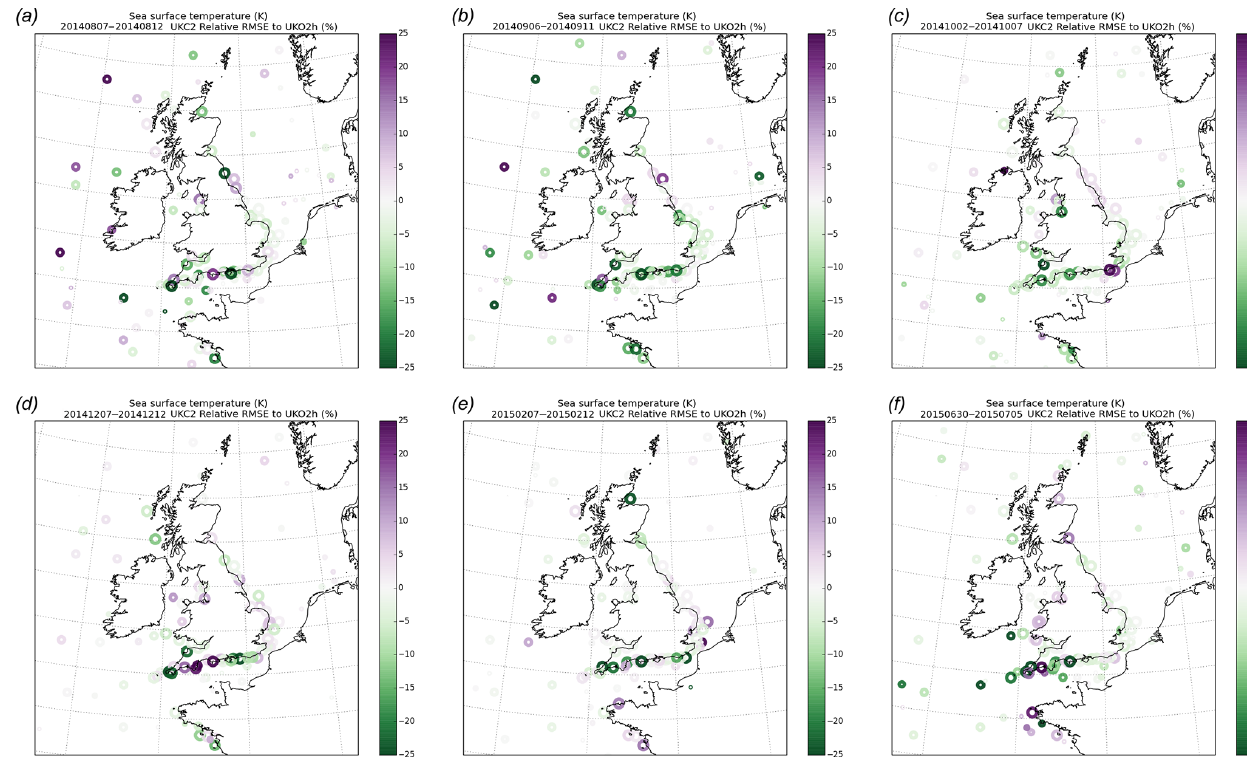
Figure 9. Differences in case study ocean model RMSE statistics for sea surface temperature, comparing statistics computed for the fully coupled UKC2aow simulation as a % difference relative to the ocean-only UKO2h runs with high-resolution meteorological forcing. Green sites indicate an overall reduction in RMSE relative to the control. Results are shown for 5-day case study periods in (a) August 2014, (b) September 2014, (c) October 2014, (d) December 2014, (e) February 2015 and (f) July 2015. RMSE statistics are computed by comparing UKC2aow and UKO2h model outputs with in situ observations. Note that only an inner section of the domain is presented for